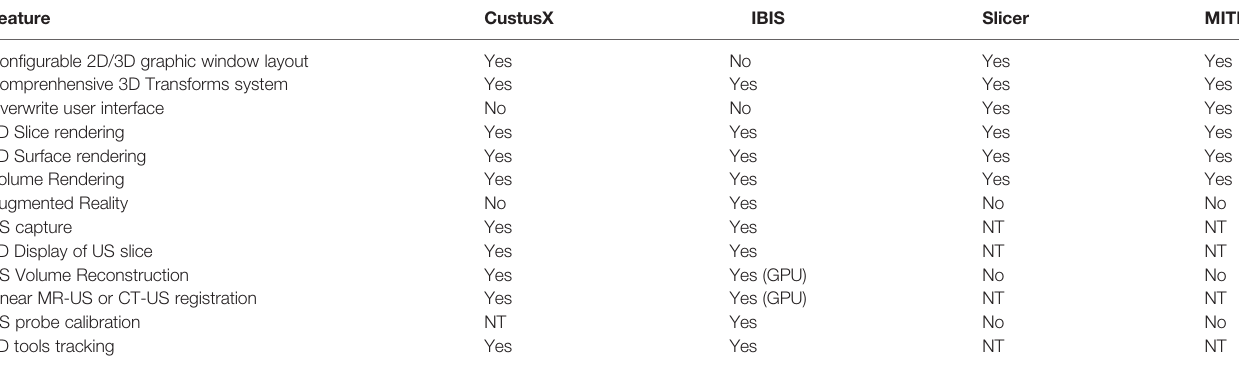
TABLE 1 | Comparison offeatures provided by different open source navigation platforms in regard of acquisition, rendering and navigation using US imaging (NT, Non-trivial). Feature